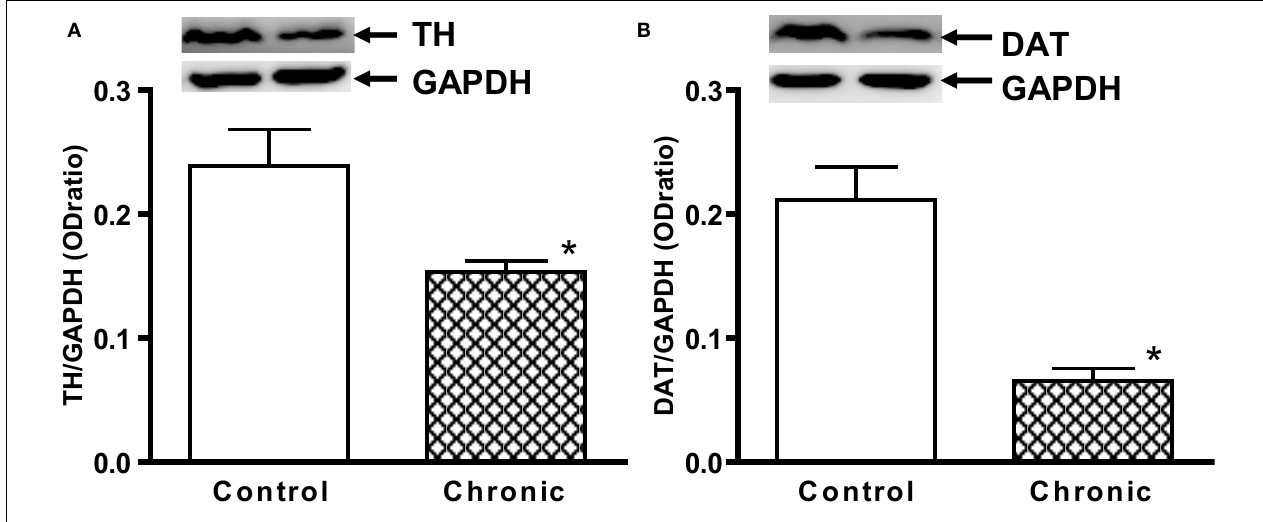
FIGURE 2 | Western blot analysis of (A) TH and (B) DAT expression in the striatum of aged chronic probenecid control and aged chronic MPD mice. A representative image of western blot protein bands was correspondingly shown above each set of bar graph. The protein contents of TH and DAT were expressed